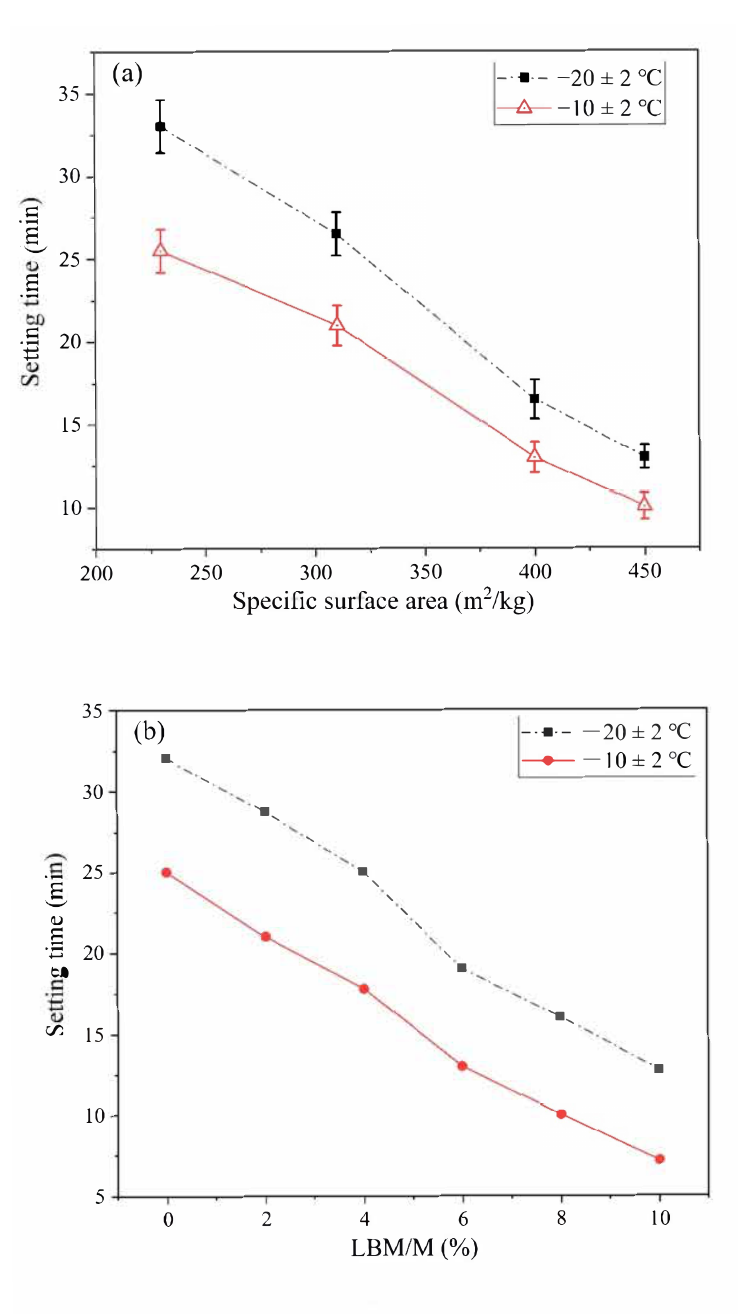
Figure 5. The influences of specific surface area (SSA) of magnesia (M) and light-burned magnesia (LBM) / M ratios on the setting time of the MPC: ( a ) SSA of M; ( b ) LBM / M